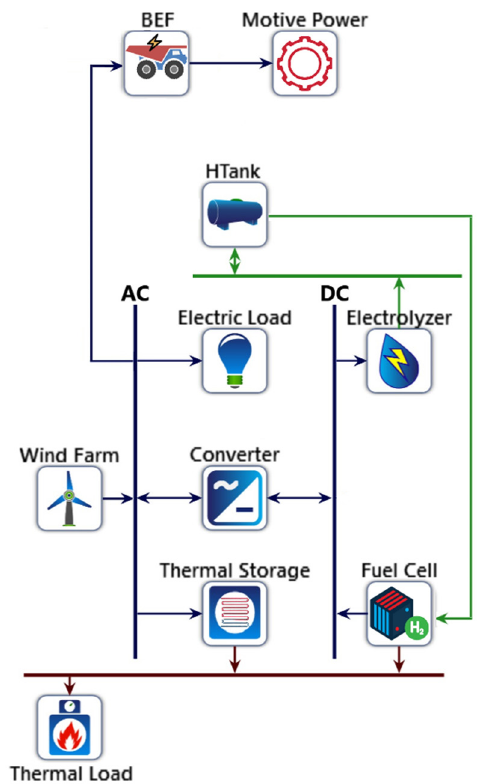
Figure 8. All-renewable system with battery electric fleet (BEF) and fc storage configuration.